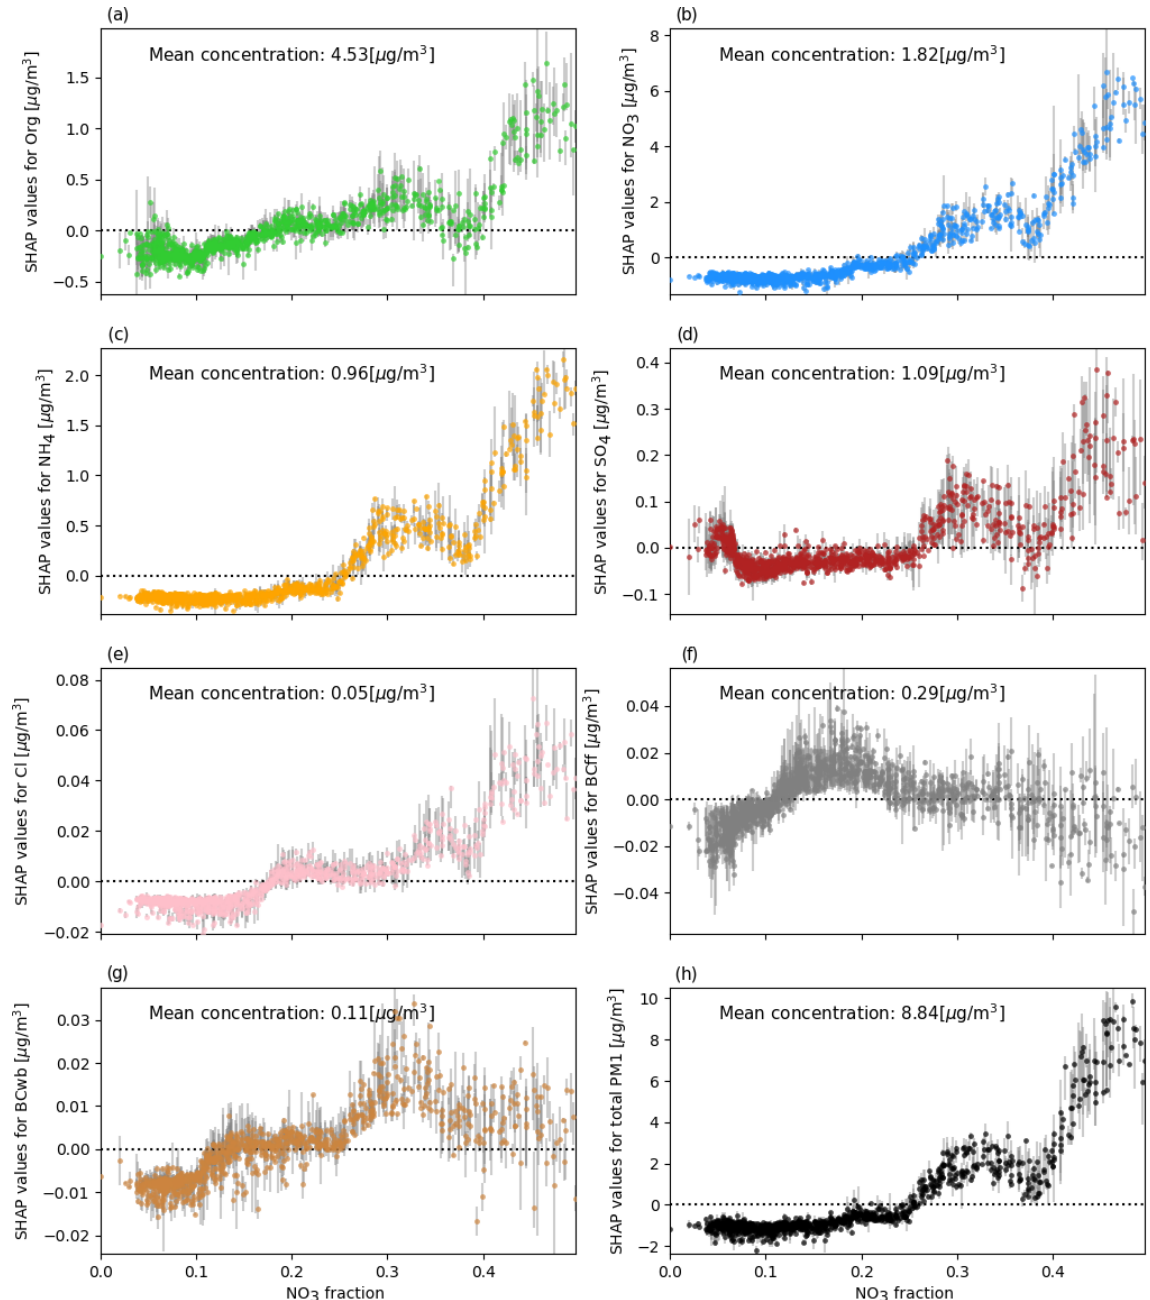
Figure B1. As Fig. 5 for fraction of NO − data instance) vs. absolute NO −